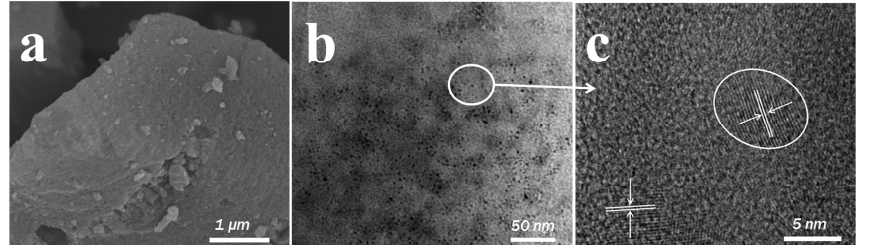
Figure 15. Microscopic images of an activated carbon/carbon quantum dot composite material: ( a ) SEM image of activated carbon; ( b , c ) high-resolution transmission electron microscope images of quantum dots. Reprinted from [242] with permission from Elsevier.